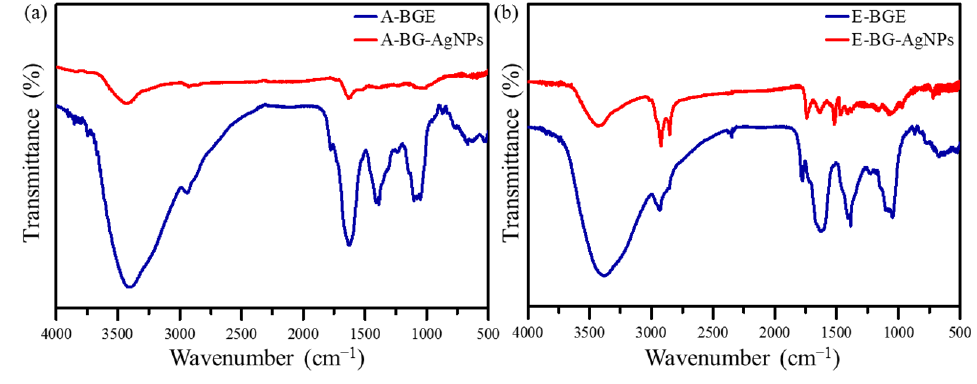
Figure 5. FT-IR spectra of ( a ) A-BGE and A-BG-AgNPs; ( b ) E-BGE and E-BG-AgNPs.